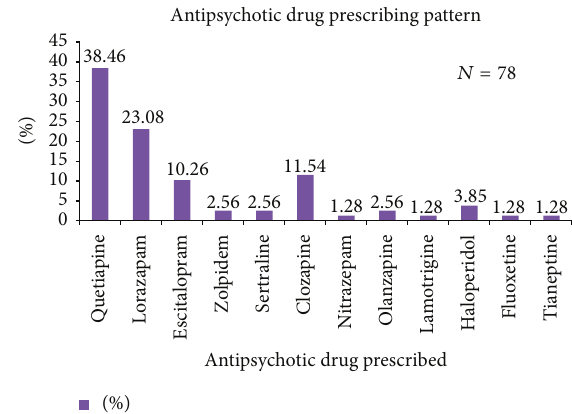
Figure 5: Depiction of antipsychotic drug prescribing pattern in dementia